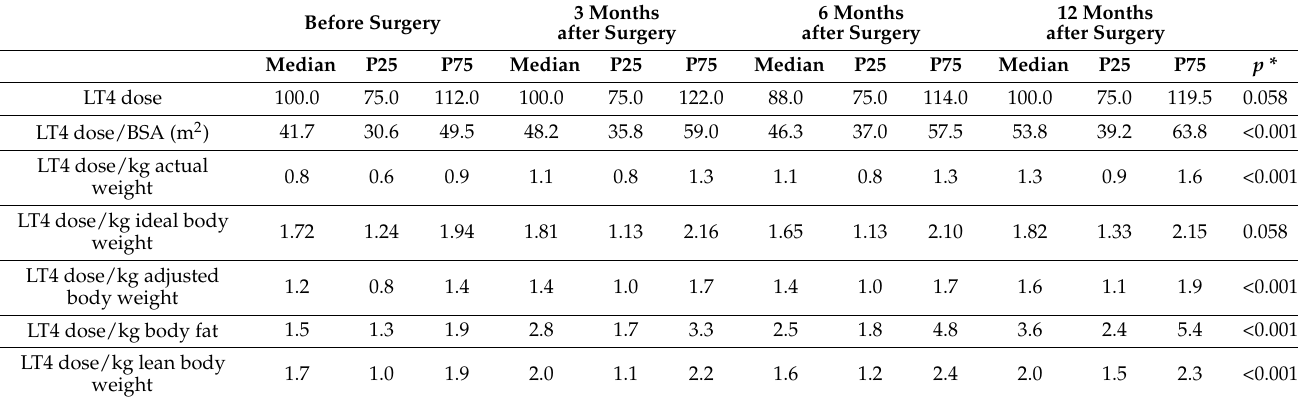
Table 3. Levothyroxine (LT4) dose (median, interquartile ranges) in hypothyroid patients before and after bariatric surgery. Before Surgery 3 Months after